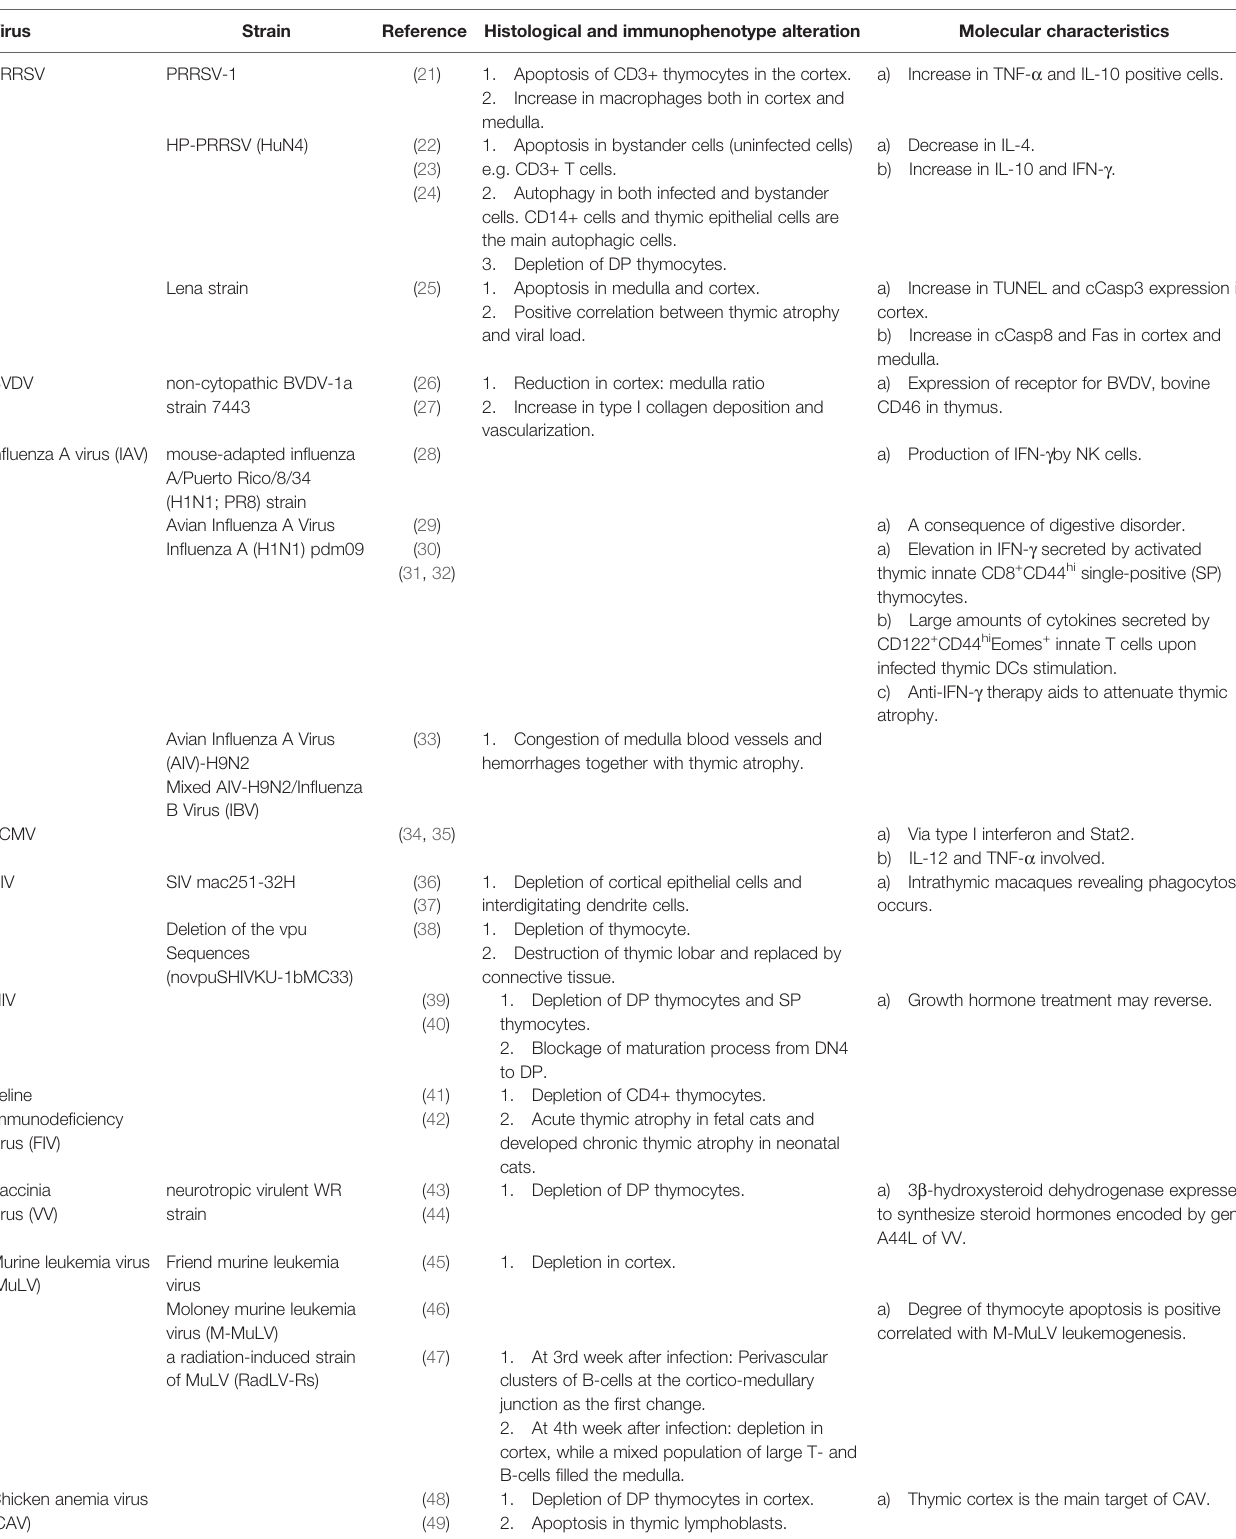
TABLE 1 | Alterations and characteristics of virus-induced thymic